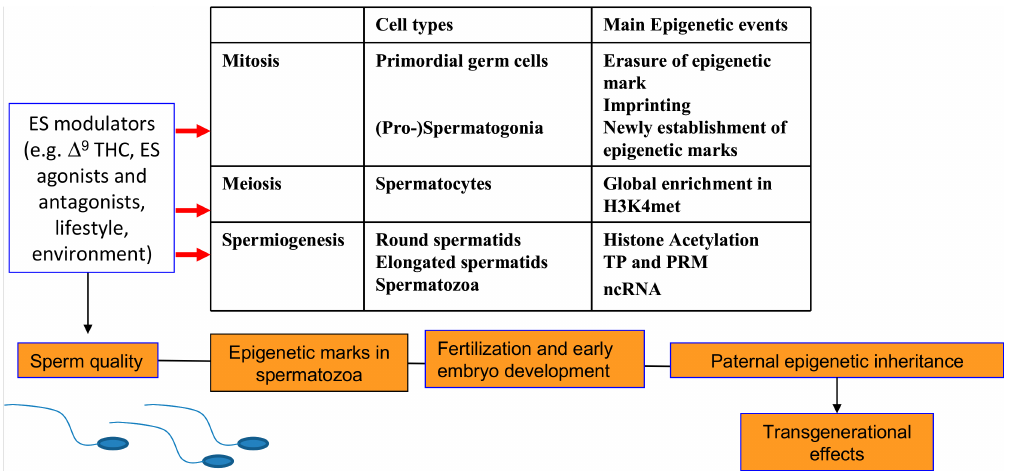
Figure 2. A summary of the main epigenetic changes occurring during the spermatogenesis and the e ff ects of ES modulation. PRM: protamine; TP: transition protein; ncRNA: non-coding